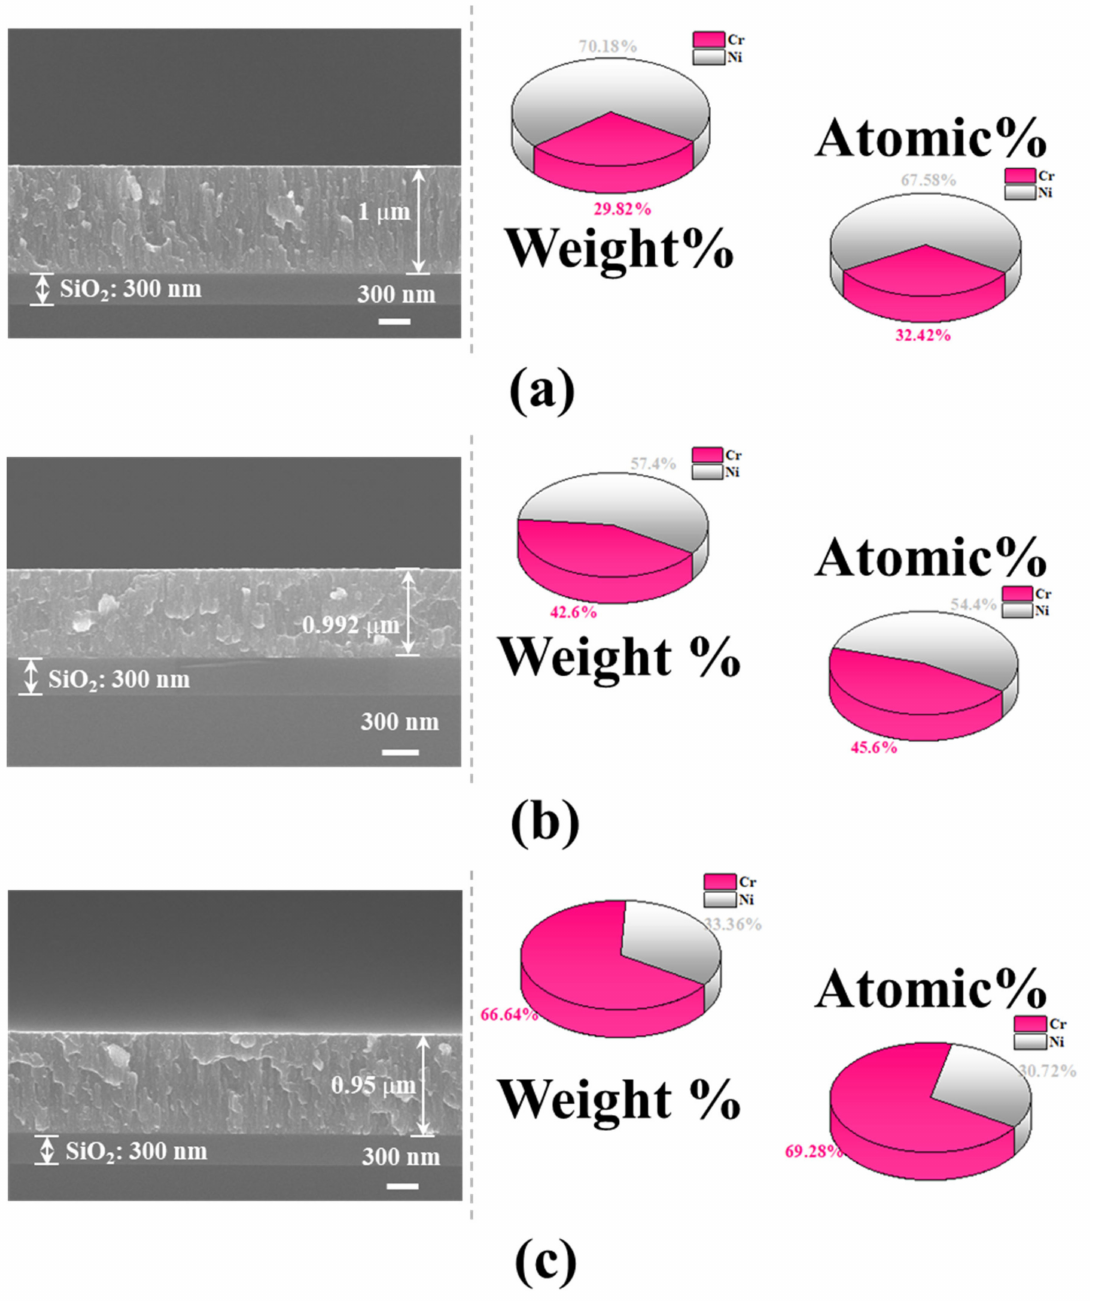
Figure 5. FE-SEM image ( left ) and EDS component analysis of the samples ( right ): ( a ) 3:1, ( b ) 2:1, and ( c )